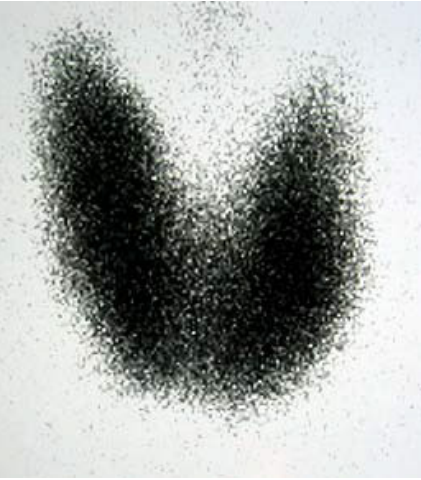
Figure 1. Radioactive Iodine Uptake Revealing Diffusely Increased